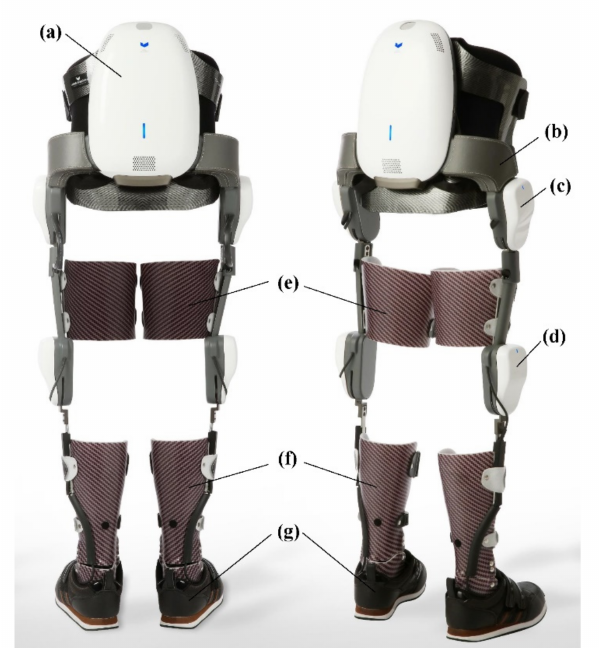
Figure 1. The powered exoskeleton used in the clinical experiments. ( a ) A controller back-pack including a battery, ( b ) a pelvic frame that rigidly supports the backpack and connects two hip joint actuators, ( c ) hip joint actuators, ( d ) knee joint actuators, ( e ) thigh bands, ( f ) ankle-foot-orthosis, and ( g ) shoes. The ground contact sensors are installed under the sole of the